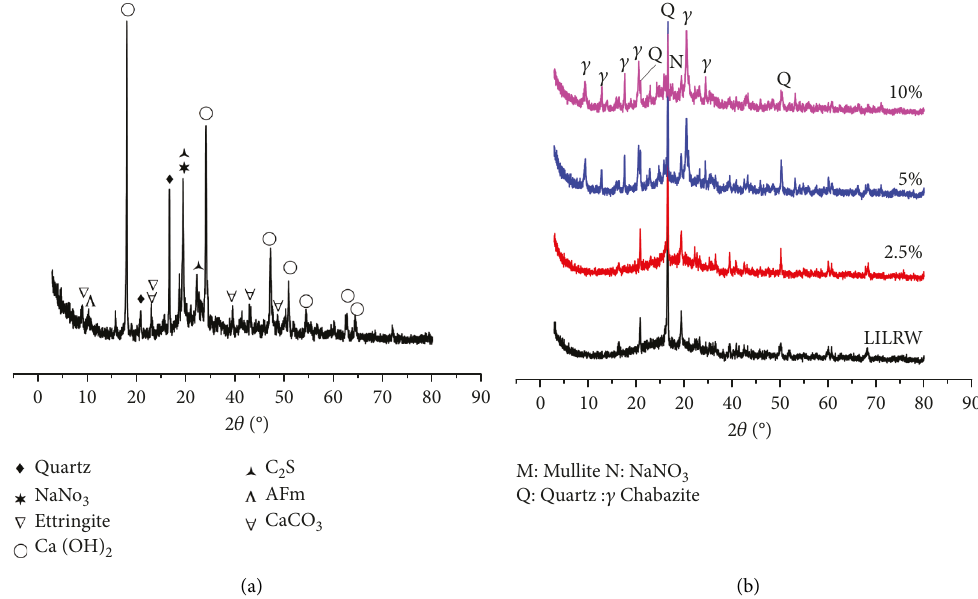
Figure 1: XRD patterns of waste forms of simulated LILRW: (a) cement waste forms; (b) fly ash/cement waste forms, 0.82% ∼ 10%